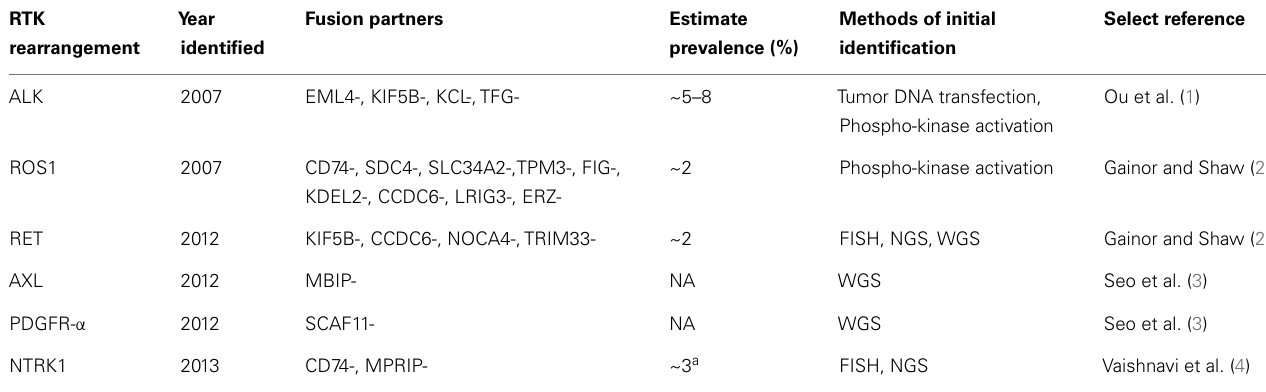
Table 1 | Characteristics of RTK rearrangement in